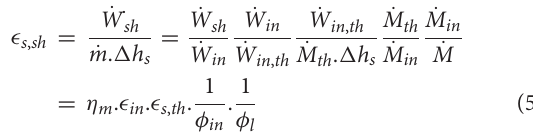
Frontiers in Energy Research |